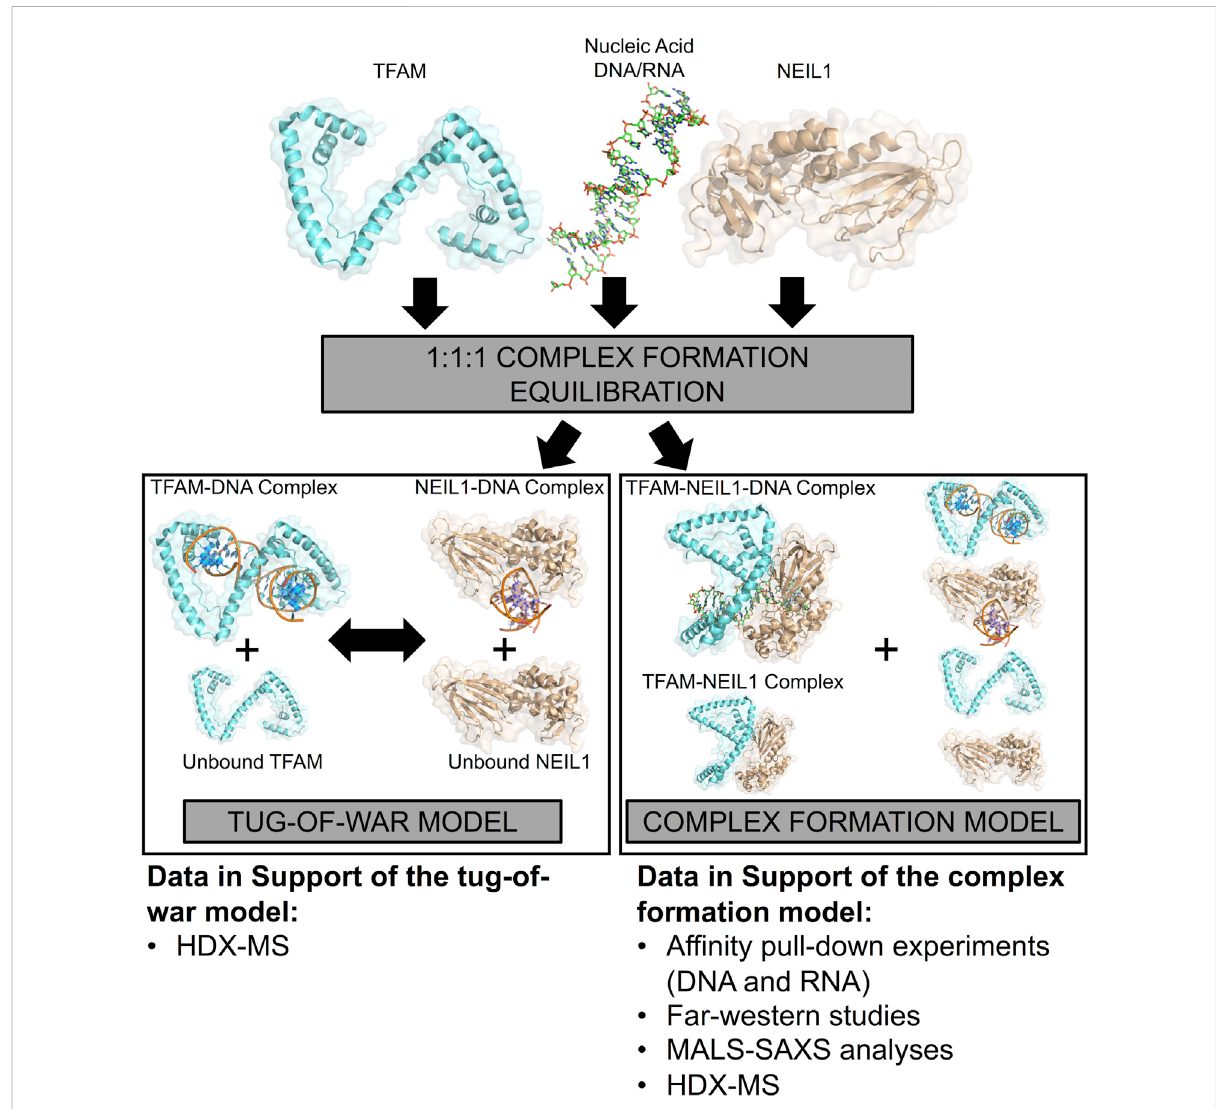
FIGURE 11 AmodelrepresentingtheinteractionbetweenNEIL1andTFAMinthepresenceandabsenceofnucleicacidbindingpartners.Twoscenariosare possible, when NEIL1, TFAM, and DNA are mixed in a 1:1:1 M ratio. In the tug-of-war model, the two proteins compete to form protein-DNA complexes, whereas, in the complex formation model, a small fraction of both proteins interact in the presence and absence of DNA, forming a complex. Species containing protein-DNA complexes or unbound-protein/DNA are also possible in this scenario. The HDX-MS data alone are insuf fi cient to distinguish between the two proposed models but support for the complex formation model is also provided by pull-down, far- western, MALS, and SAXS